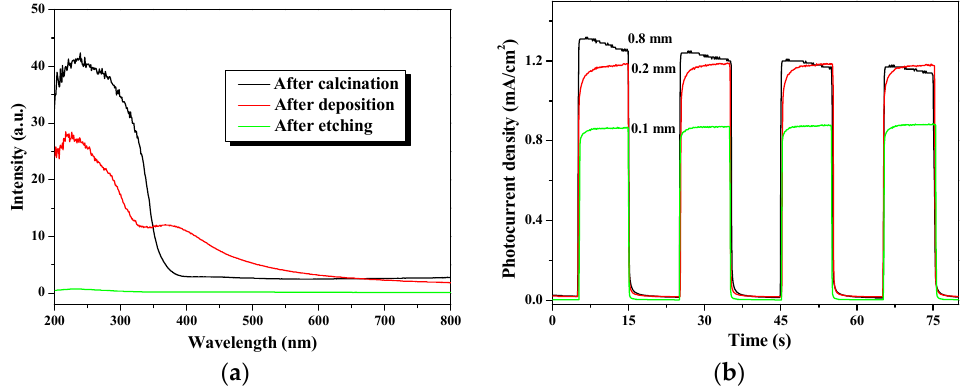
Figure 5. ( a ) Diffuse reflection spectrum of TiO 2 nanowire arrays; ( b ) photocurrent of TiO 2 nanowire arrays deposited on the Ti plate with different thicknesses.